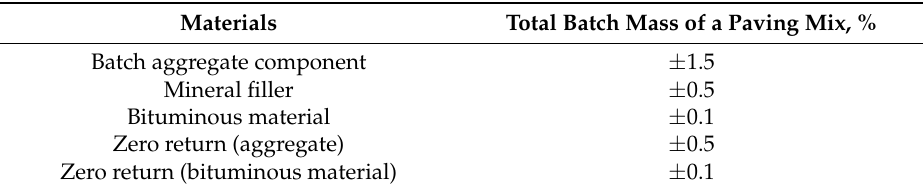
Table 4. Tolerances of batch masses of AMP batchers’ materials according to ASTM D